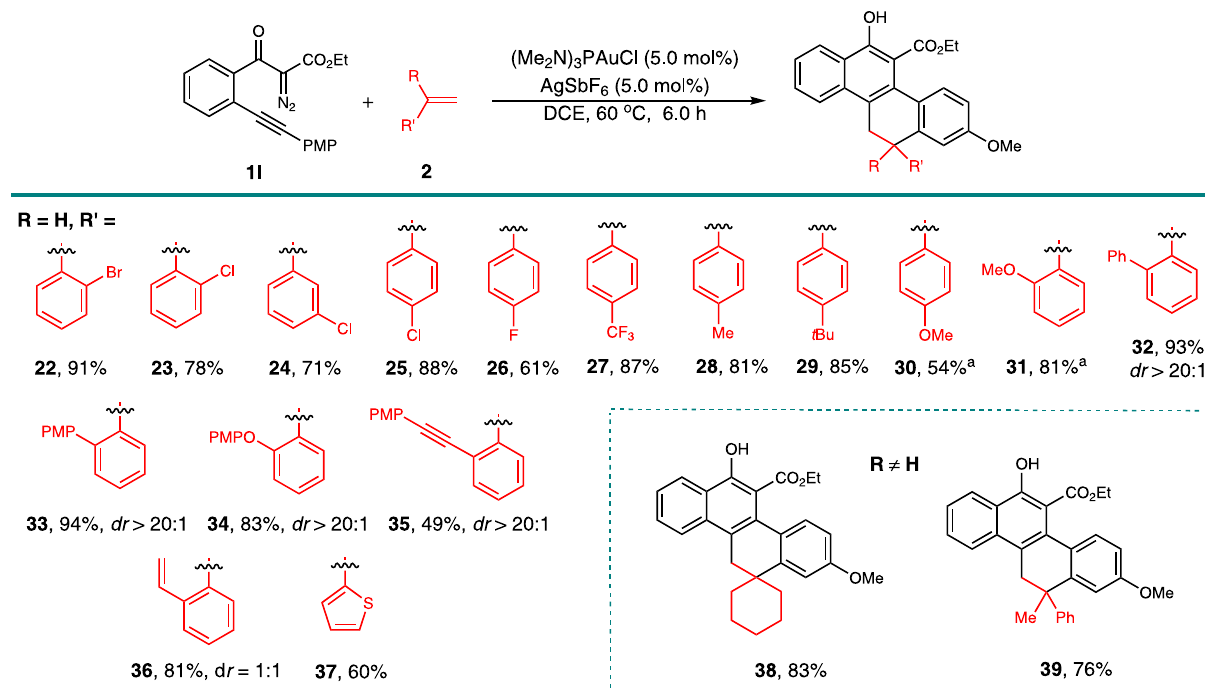
Fig. 3 Scope with respect to the ole fi ns 2. Reaction condition: to a solution of (Me 2 N) 3 PAuCl (3.95 mg, 0.01 mmol), and AgSbF 6 (3.4 mg, 0.01 mmol) in DCE (0.5 mL), we added a solution of 1 l (PMP = 4-MeOC 6 H 4 , 69.6 mg, 0.2 mmol) and ole fi ns 2 (0.3 mmol) in DCE (0.5 mL) at 60 °C, then the reaction mixture was stirred for 6 h under these conditions. Isolated yields are listed. a DCE (6.0 mL) was